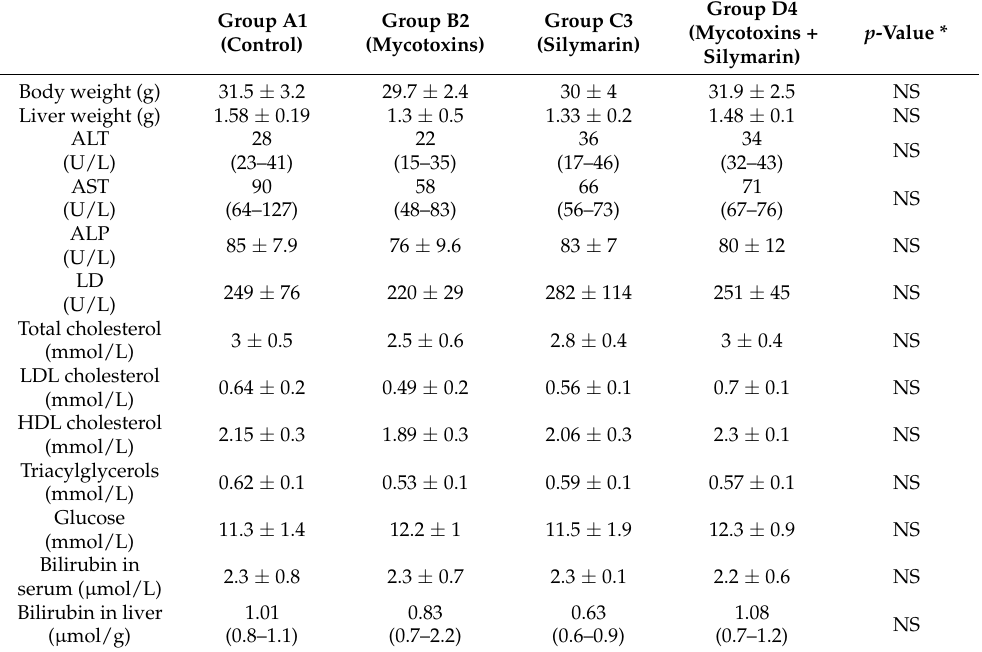
Table 2. The effect of mycotoxin exposure and silymarin treatment on clinical characteristics of mice fed high-fat MCD diet. Data expressed as mean ± SD or median and IQ range depending on their